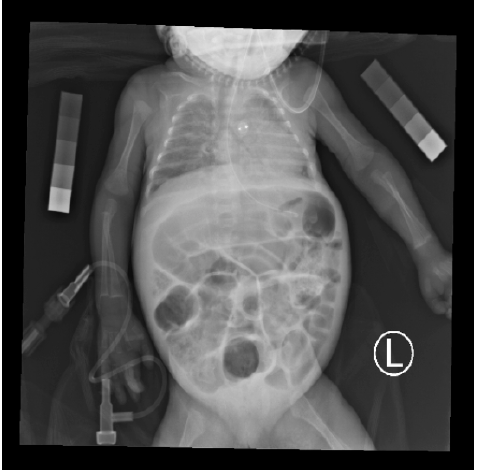
Figure 1. A chest X-ray image of a premature infant with standardized density phantoms.